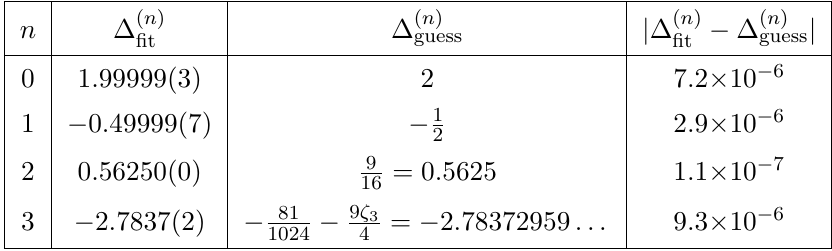
Table 2 . Strong coupling coe(cid:14)cients for L = 1, S =